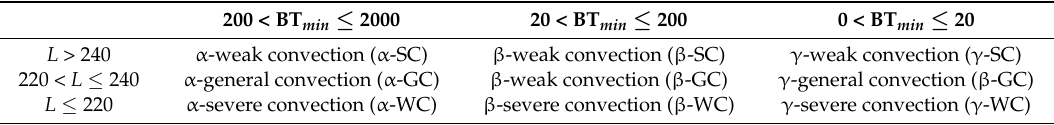
Table 1. Classification standard of convective cloud clusters (L: km; BT min :